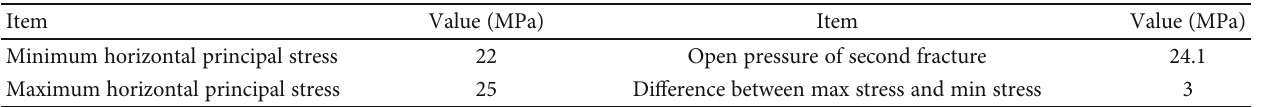
Figure 2: The phase – permeability curves of the matrix and fracture. (a) Matrix phase permeability curve and (b) fracture phase permeability curve. Table 2: Formation pressure